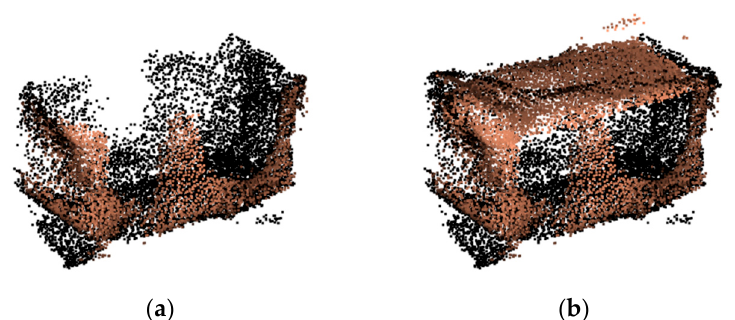
Figure 13. Example of missing surface repair effect: ( a ) before repair; ( b ) after repair.